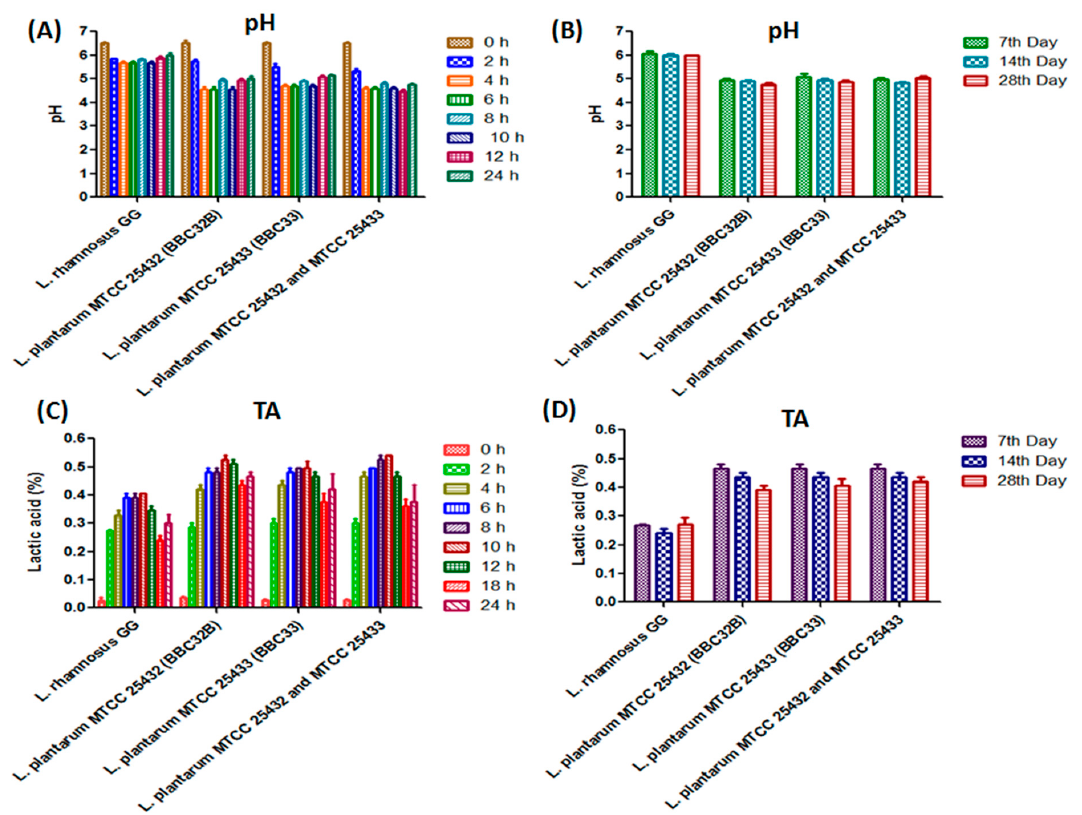
Figure 2. Lactic acid production and pH stability; A sudden fall in pH of the soymilk fermented with L. plantarum MTCC 25433 (BBC33), L. plantarum MTCC 25432 (BBC32B) and combination of L. plantarum MTCC 25432 (BBC32B) and MTCC 25433 (BBC33) as compared to L. rhamnosus GG after 4th h ( A ). Almost equal pH stability up to 28 days after fermentation ( B ). A continues increase in lactic acid production in the soymilk fermented with L. plantarum MTCC 25433 (BBC33), L. plantarum MTCC 25432 (BBC32B) and combination of L. plantarum MTCC 25432 (BBC32B) and MTCC 25433 (BBC33) as compared to L. rhamnosus GG after 2nd h to 10th h of fermentation ( C ) and then a stable lactic acid production upto 28 days ( D ). The values are expressed as mean ±SEM of three independent experiments with significant difference ( p <0.0001).